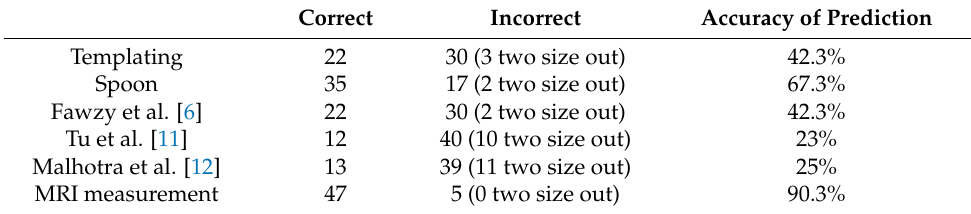
Table 1. Accuracy of template, sizing spoon, previous guidelines and MRI measurement. Correct Incorrect Accuracy of Prediction